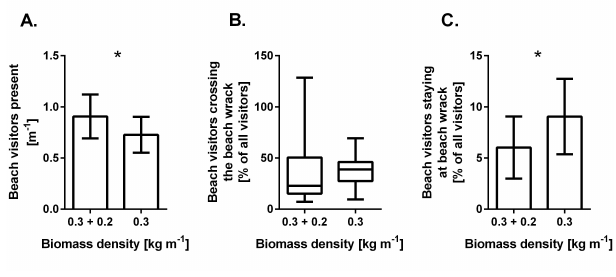
Fig. 5 . Effect of 0.3 kg m-1 of Zostera beach wrack with and without addition of 0.2 kg m-1 of Ceramium beach wrack on (A.) the density of visitors at two adjacent beach sections within time intervals of 30 min, (B.) the frequency of these visitors crossing the beach wrack and (C.) the frequency of these visitors staying in direct vicinity of the beach wrack for 30 s or more time. Repeated measurements were conducted in time intervals of 30 min between noon and 5 pm and treated as replicates (n = 10). Average ± SD is shown in (A.) and (C.), while median ± quartiles is shown in (B.). Asterisks indicate pairs of groups that are significantly different (p < 0.05; tested with paired t-test in (A.) and (C.) and with Wilcoxon matched pairs signed rank test in (B.).